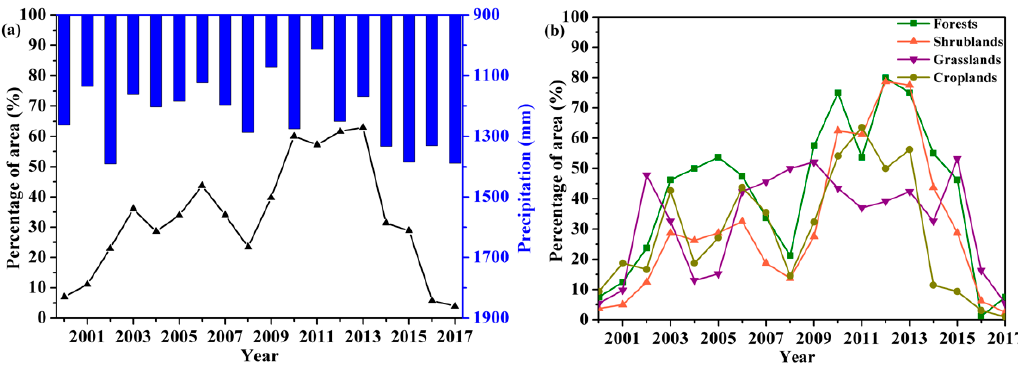
Figure 2. The interannual variations of the drought area (scPDSI < − 1) and precipitation in Southwest China over the period 2000–2017: ( a ) the drought area and annual precipitation for all vegetated grid cells; ( b ) the drought area for different vegetation types.